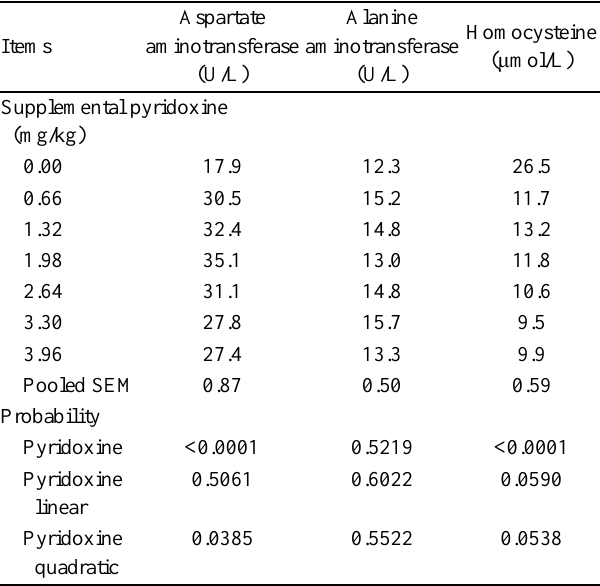
SEM, standard error of the mean. 1 Results were means with n = 7 per